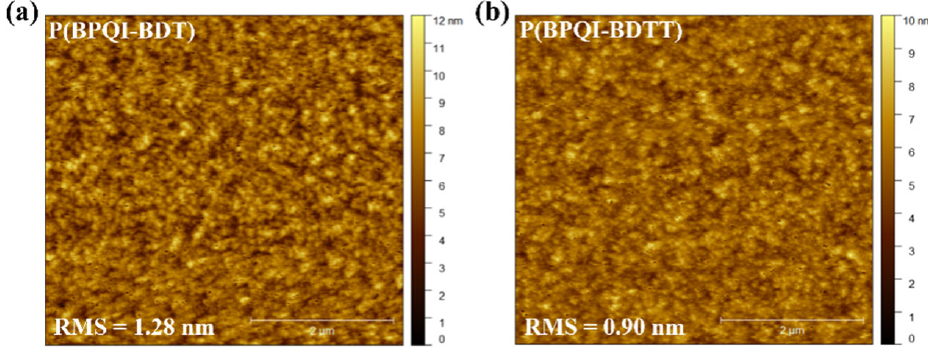
Figure 4. AFM phase images of ( a ) P(BPQI ‐ BDT) and ( b ) P(BPQI ‐ BDTT) blend films, respectively.